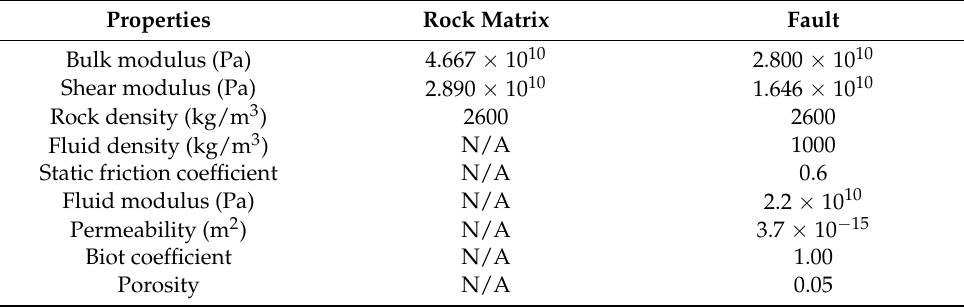
Figure 3. The model geometry and meshes used in the study. ( a ) A 3D view of the grid. ( b ) Plane view of the fault zone in the Y–Z plane. The triangle denotes the fluid intrusion point. Table 1. Parameters for the rock matrix, fault, and fluid for the numerical